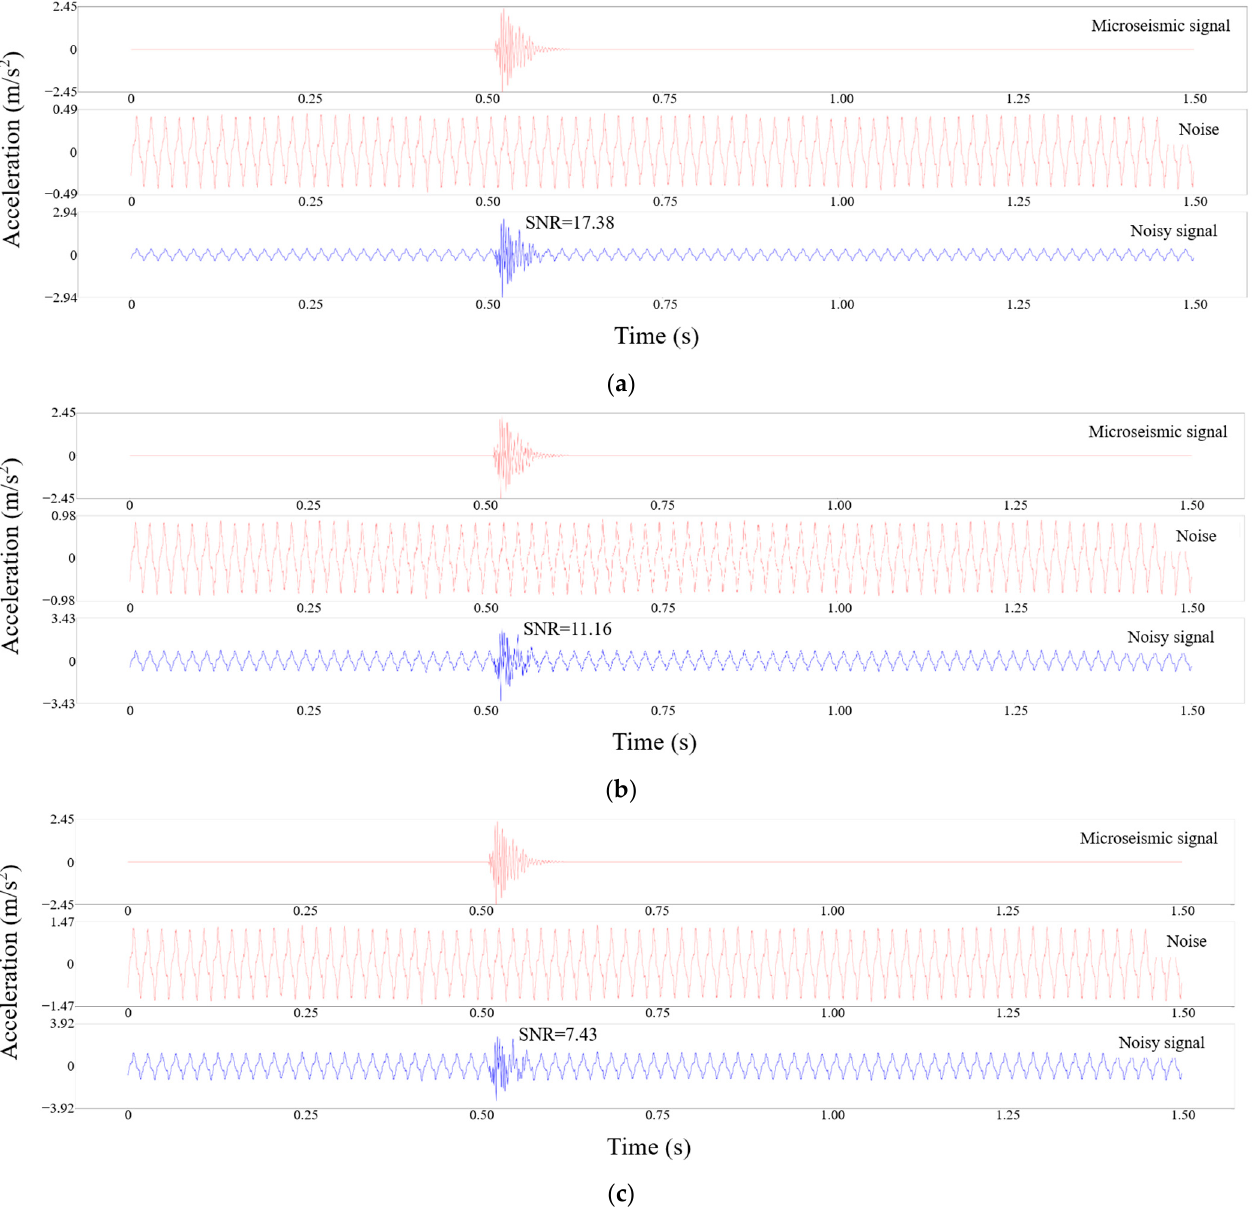
Figure 5. Composite diagram of noisy signals with different SNRs. ( a ) Noisy signal SNR of 17.38 dB. ( b ) Noisy signal SNR of 11.16 dB. ( c ) Noisy signal SNR of 7.43 dB. Considering the frequency distribution of the clean microseismic signal and clean noise, the cutoff frequency of the high-pass filter was set to 80 Hz to achieve the best de- noising effect. For STA/LTA, the optimal threshold was selected to achieve the most accu- rate onset time pickup. Figure 6a shows the SNR curve after denoising using PDTN and the high-pass filter. Figure 6a shows the SNR curve after denoising using PDTN, high- pass filter, and DnCNN. The average SNR of the noisy signals was 6.55 dB. The average SNR of the signals denoised using the high-pass filter, DnCNN, and PDTN was 15.02 dB, 12.54 dB, and 25.51 dB, respectively. Compared with the DnCNN, the PDTN improved the SNR by 12.97 dB on average and achieved better denoising effect in the entire SNR range. Compared with the high-pass filter, the PDTN improved the SNR by 10.49 dB on average and achieved better denoising effect in the entire SNR range. The correlation co- efficient can indicate the correlation among signals. The closer the correlation coefficient is to 1, the greater the similarity between two signals. The correlation coefficients between